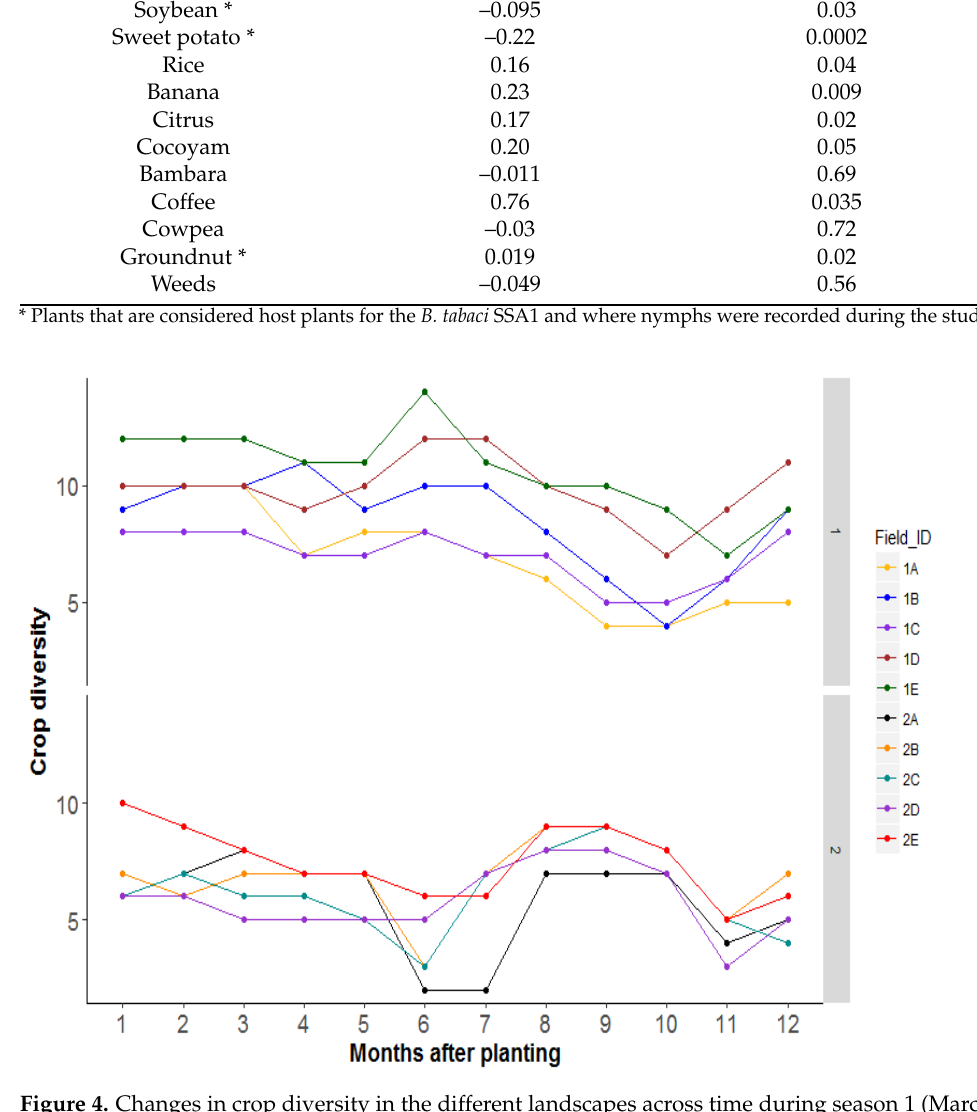
Figure 4. Changes in crop diversity in the different landscapes across time during season 1 (March– February) and season 2